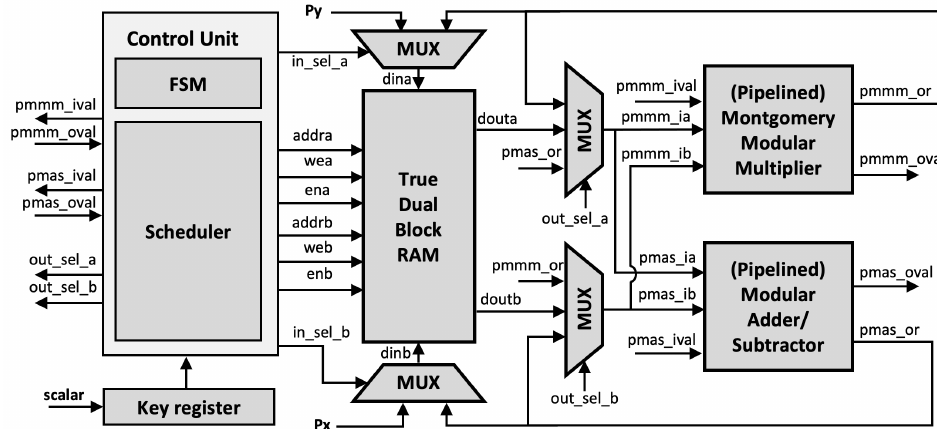
Figure 9. Proposed elliptic curve cryptography (ECC) architecture. Unified Architecture